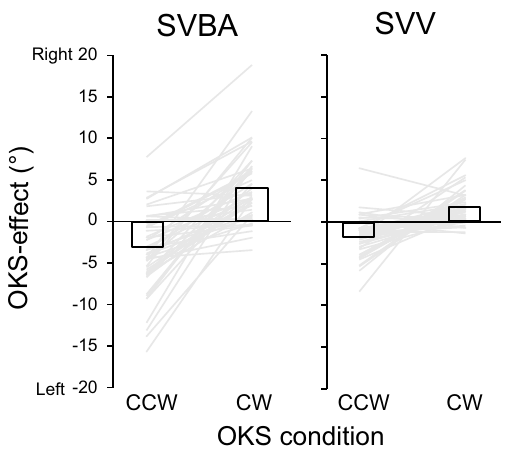
Figure 2. Effect of optokinetic stimulation (OKS-effect) on adjustment errors in the SVBA or SVV tasks. Gray- colored lines represent averaged values of each participant, and black-colored bars represent errors averaged across all participants. As illustrated, both SVBA and SVV were biased toward the rotation direction of OKS. CW clockwise, CCW counterclockwise.